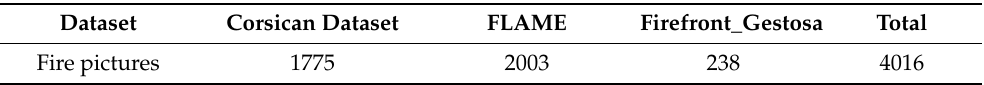
Table 3. Statistics about the data used to train and test the detection module in terms of the number of samples.